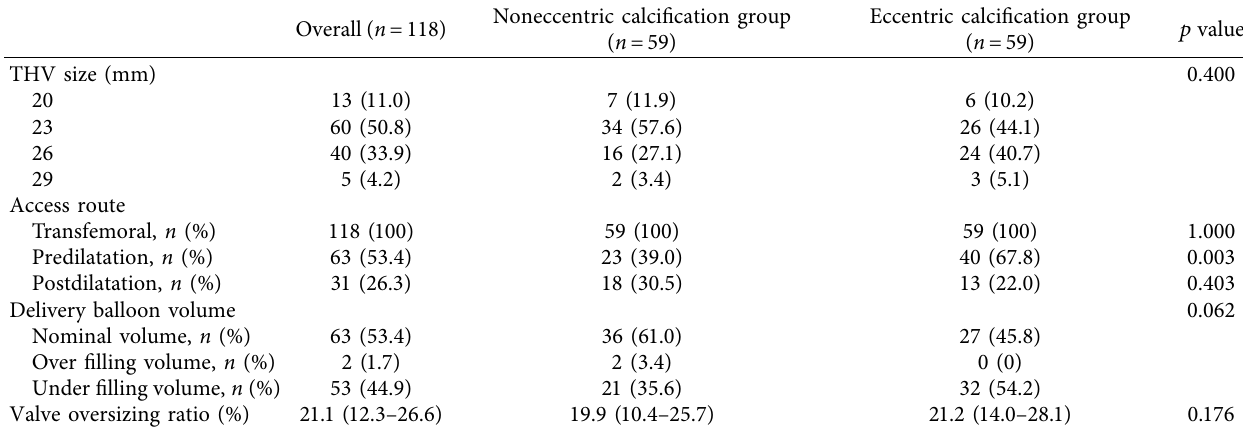
Table 3: Procedural details.